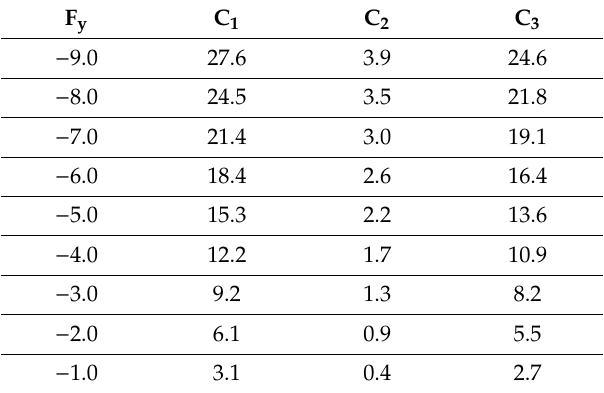
Table 1. Relationship between vertical force Fy and each of radii of circles C 1 , C 2 , and C 3 . Tensional force T was fixed as 10 N. Units of F y and the radius are [N] and [mm], respectively.